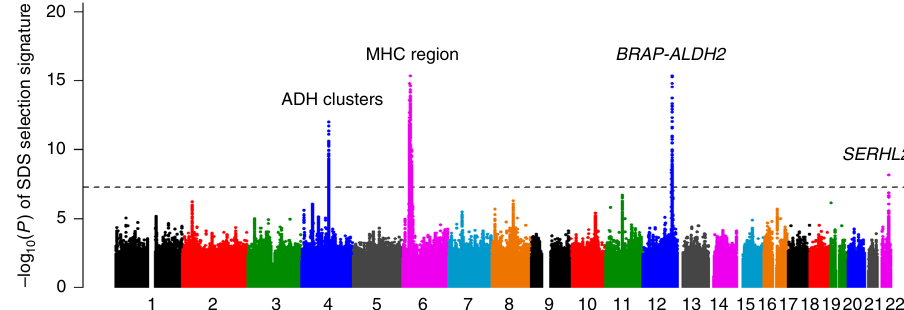
Fig. 3 Genome-wide very recent natural selection signatures of the Japanese population. A Manhattan plot of the genome-wide natural selection signatures obtained from the WGS data of 2234 Japanese individuals. The y -axis indicates the – log 10 ( P ) of a genome-wide selection signature calculated by using SDS 9 . The horizontal gray line represents the genome-wide signi fi cance threshold ( P < 5.0 × 10 -8